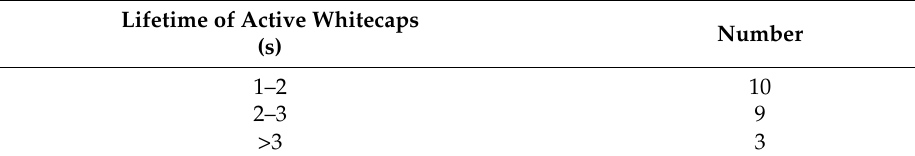
Table 1. Lifetime of active whitecaps in this study.